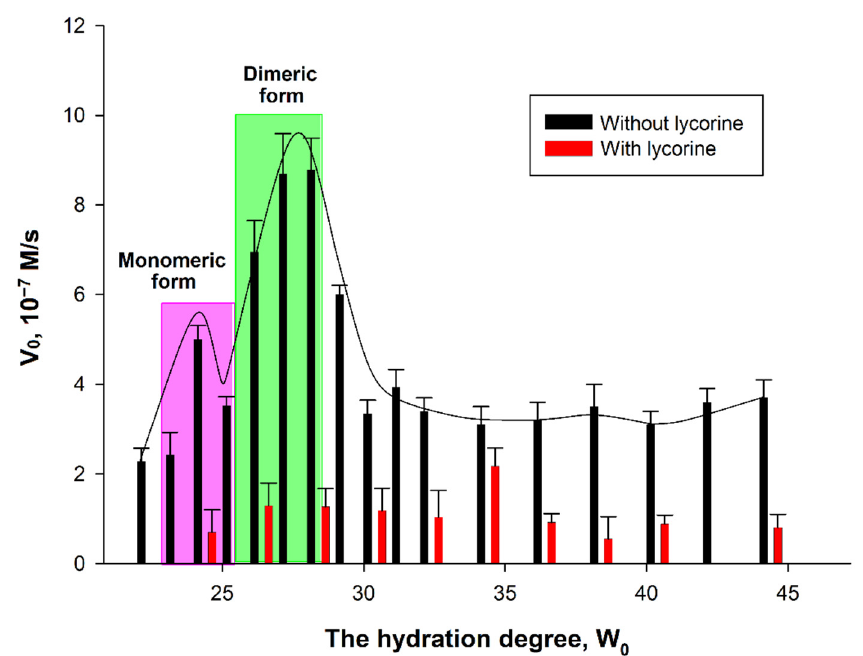
Figure 7. Dependence of AtGALDH activity on the hydration degree in the absence and presence of 800 µ M lycorine. The monomeric and dimeric forms of the enzymes were observed at hydration degrees W 0 = 23–25 and 26–28, respectively. The concentrations of AtGALDH and L -galactone-1,4-lactone were 6 × 10 − 9 M and 1 mM, respectively. Values are presented as the mean ± SD of three experiments.